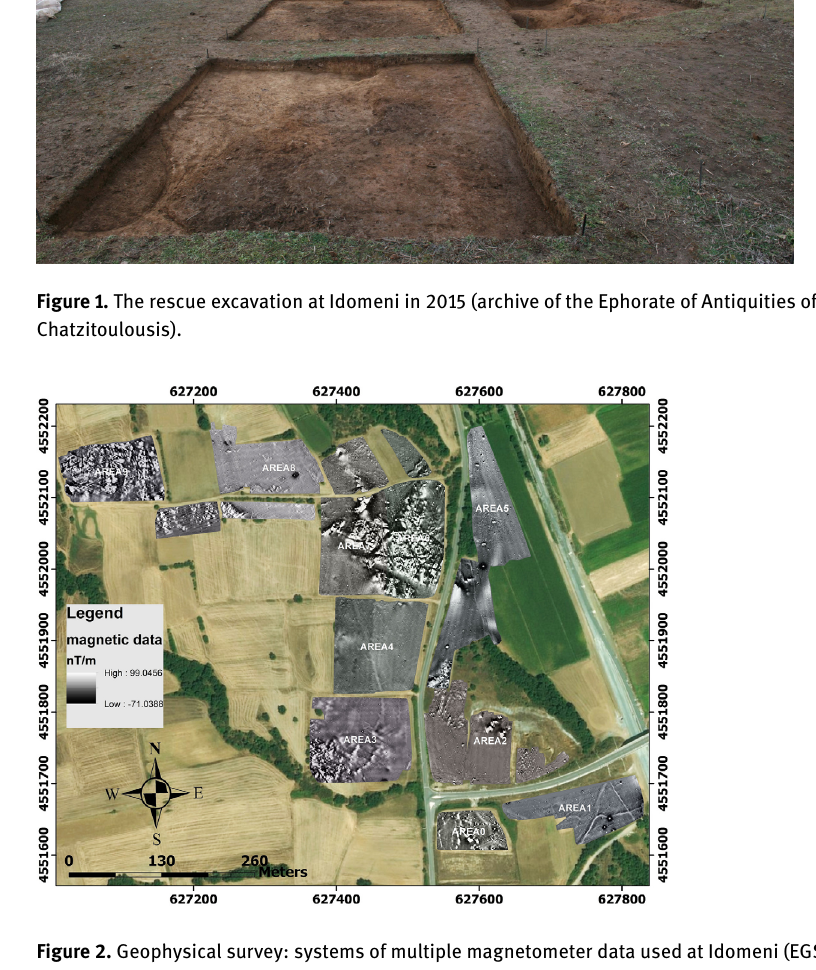
Figure 2. Geophysical survey: systems of multiple magnetometer data used at Idomeni (EGSA 1987, Greek national Grid).